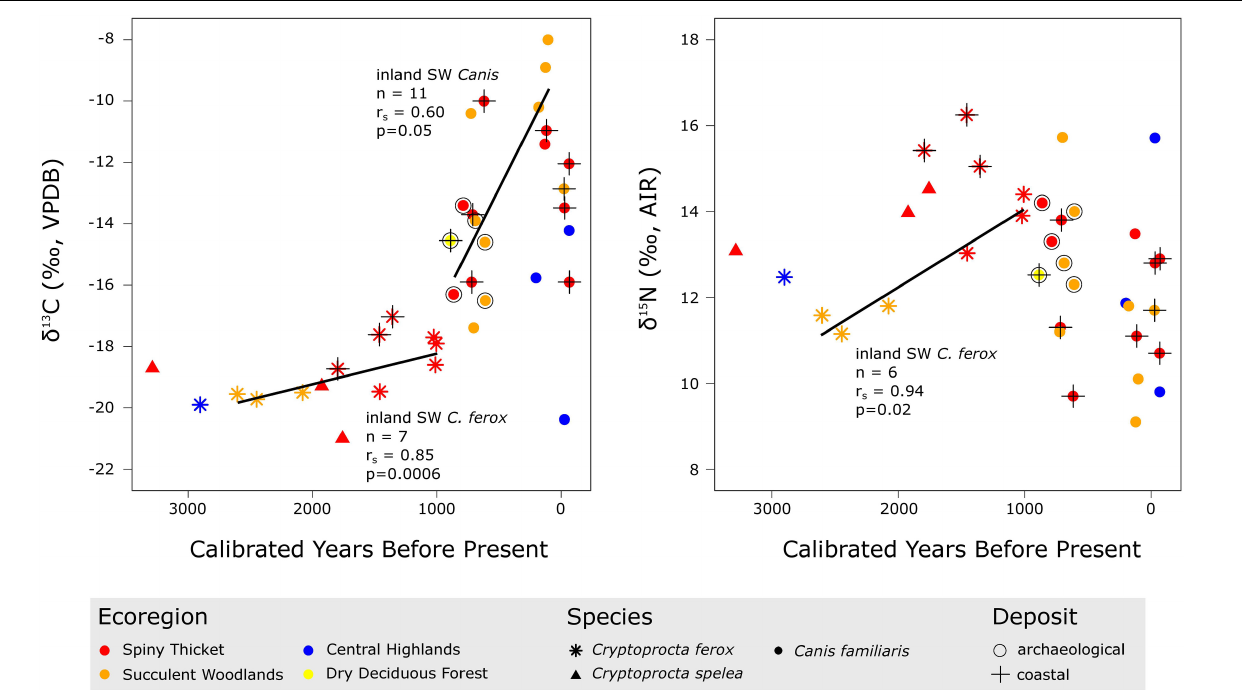
FIGURE 7 | Temporal trends in stable carbon and nitrogen isotope data for bone collagen from dogs (both modern and subfossil) and members of Cryptoprocta (all subfossil), with points colored according to ecoregion, shaped according to taxon, and marked according to deposit type ( δ 13 C n = 37, δ 15 N n = 36). The six modern dogs have δ 13 C values that are corrected for the Suess Effect (following Crowley and Godfrey, 2013) so that they are comparable with subfossil collagen values. Trend lines illustrate the only significant temporal trends when controlling for region and coastal proximity: In inland SW Madagascar (including both spiny thicket and succulent woodlands), dog and C. ferox δ 13 C values and C. ferox δ 15 N values significantly increased through time, yet these trends could be explained by uneven sampling across archeological versus paleontological deposits in the case of dogs or by uneven sampling between the spiny thicket and succulent woodlands in the case of C. ferox